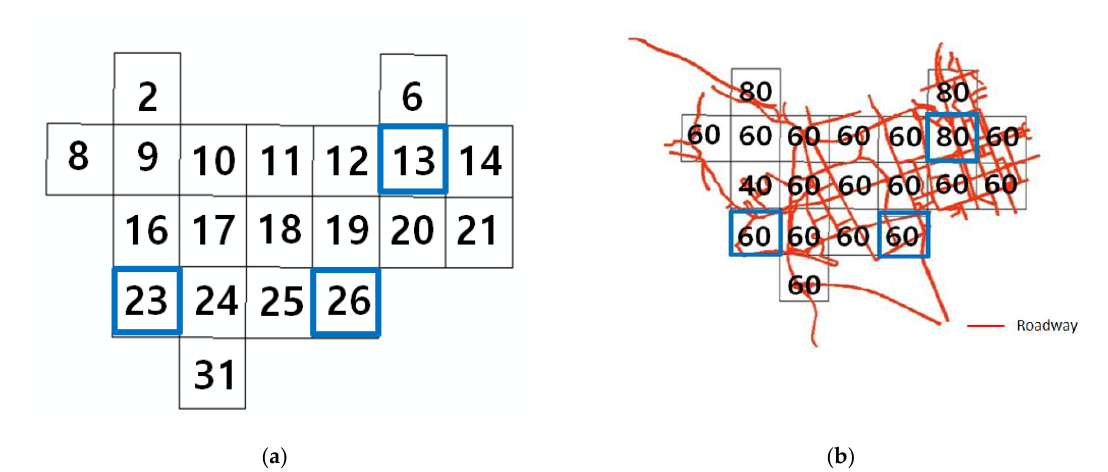
Figure 7. Sadang-dong ( a ) cell number and ( b ) speed limit for each cell.